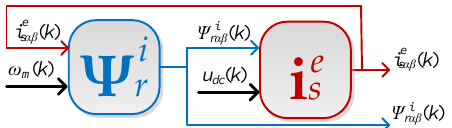
Figure 1. Block diagram of the stator current estimation based on the measurement of angular velocity and DC voltage in the VSI intermediate circuit.